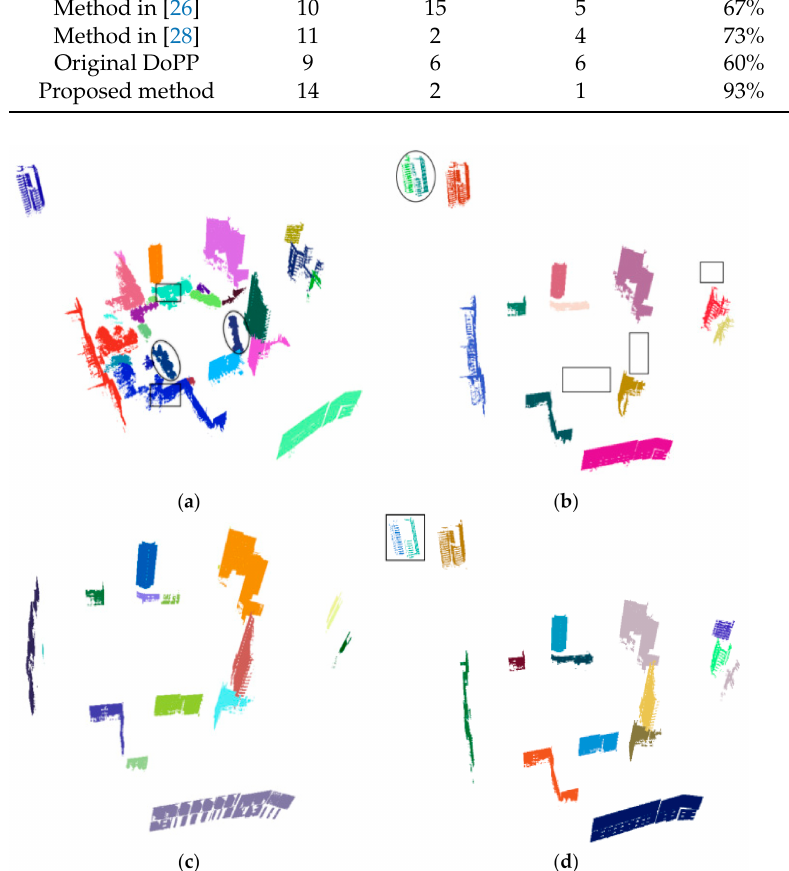
Figure 11. Extraction results for four grid-based methods. ( a ) shows the compactness-based method, ( b ) the horizontal hollow analysis, ( c ) the original DoPP, and ( d ) the proposed